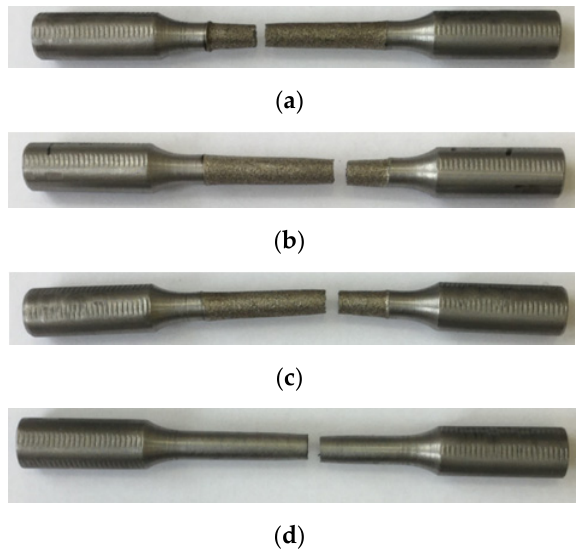
Figure 22. Photos of tensile fractured specimens made by: ( a ) EDM (copper ET); ( b ) EDM (composite ET); ( c ) EDM (graphite ET); ( d ) turning.